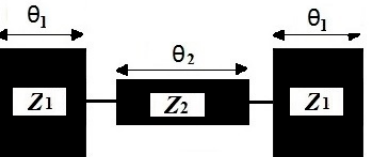
Figure 1. Configuration of the basic structure of the stepped impedance resonator (SIR), where Z 1 < K = < 1 . Z 2 (cid:3027) (cid:3118)